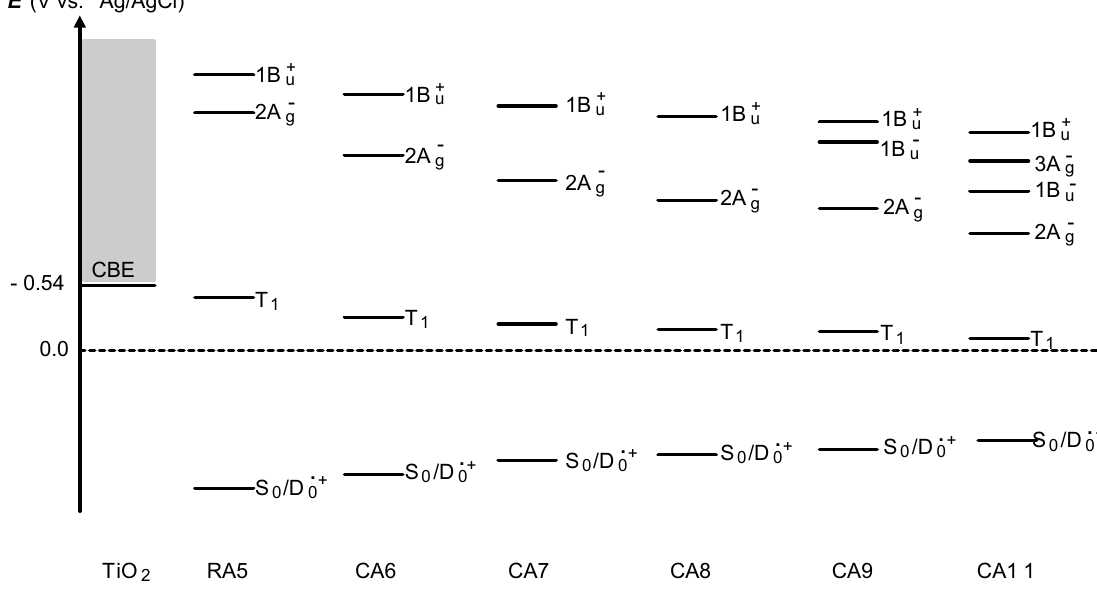
Figure 7. The energies of the singlet, triplet and redox states of RA5 and CA6–CA11 in comparison to that of the conduction-bond edge (CBE) of TiO permission of the American Chemical Society).